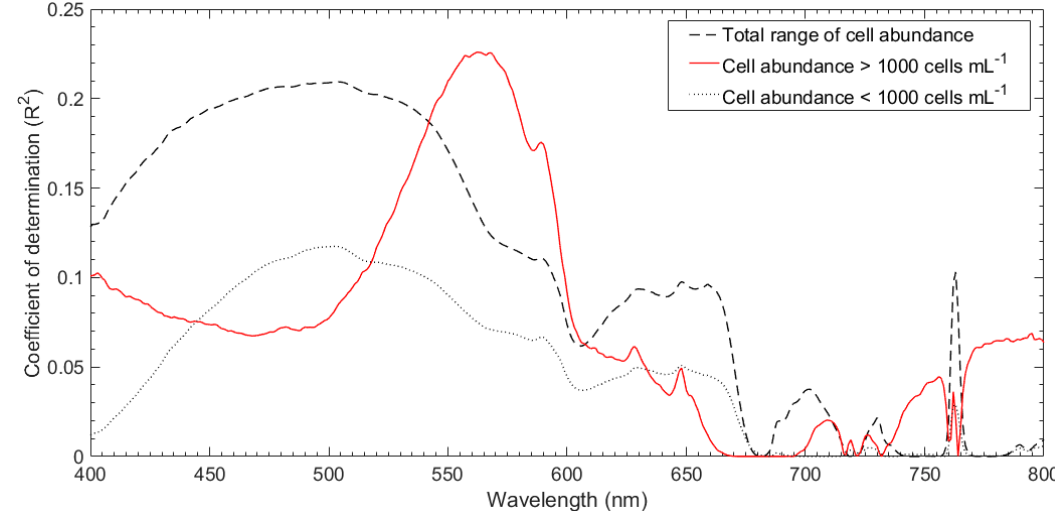
Figure 5. Coefficient of determination (R 2 ) between measured M . polykrikoides cell abundance and in situ R rs spectra for each wavelength band.